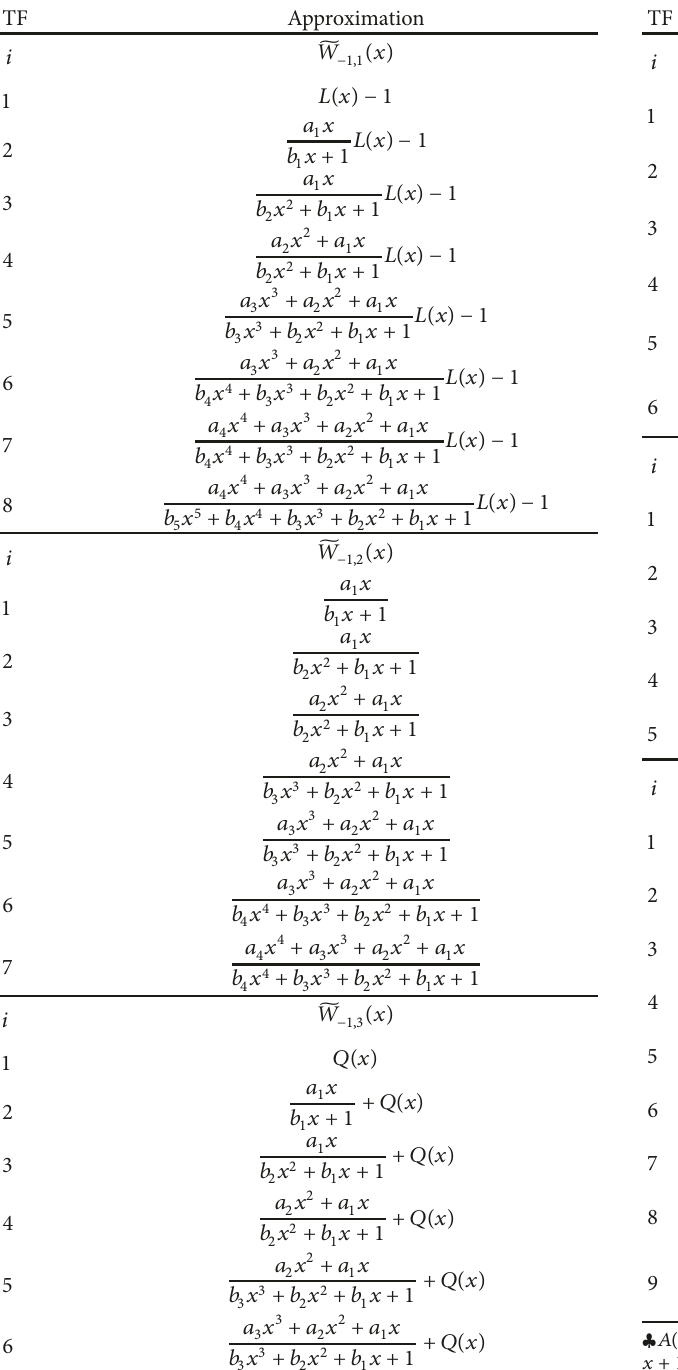
̃𝑊 (𝑥) , ̃𝑊 (𝑥) −1,1 −1,2